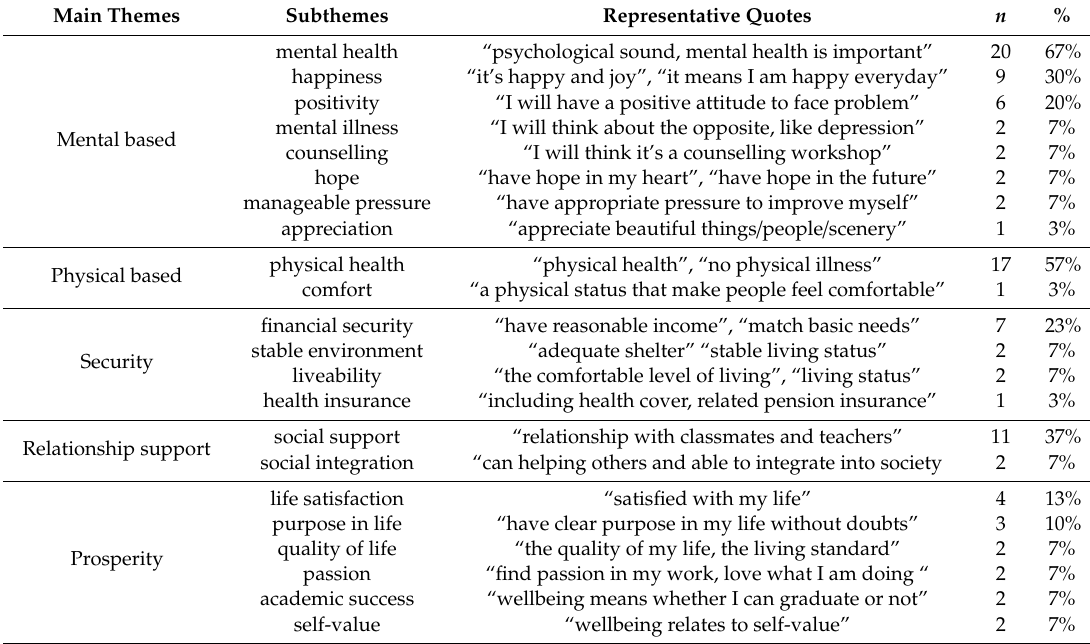
Table 2. Chinese international students’ understanding and language about